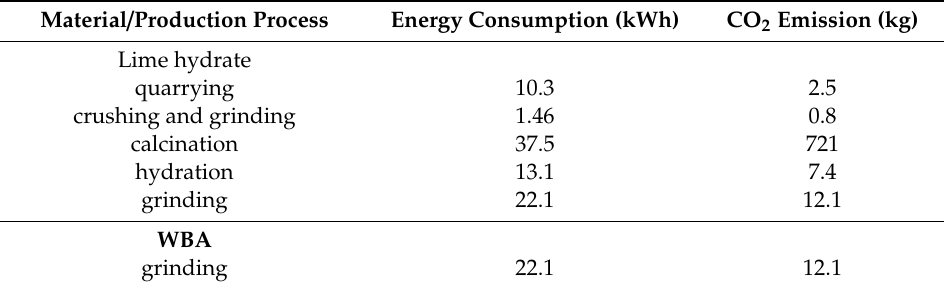
Table 2. Energy and emission inventory of the production stages (per ton of Ca(OH) 2 or WBA).